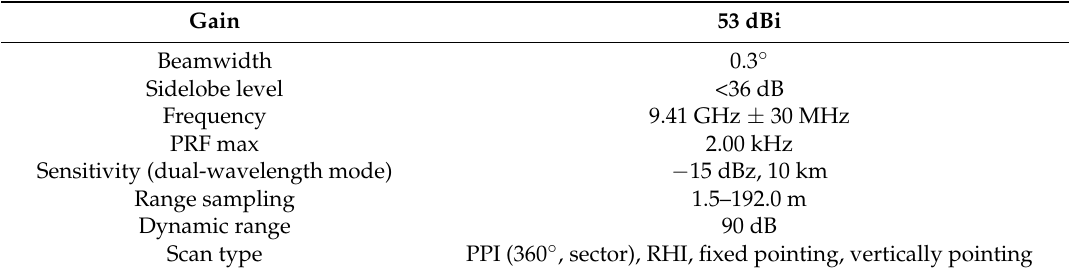
Table 1. Main specifications of the CSU–CHILL X-band radar